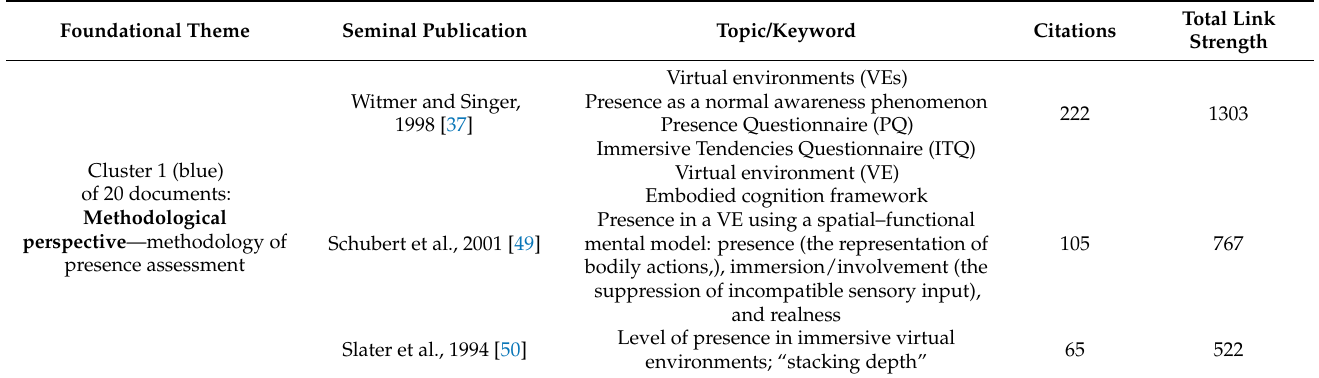
Table 9. Top 12 most co-cited publications identified through co-citation analysis of cited references showing thematic clusters and seminal publications ranked by link